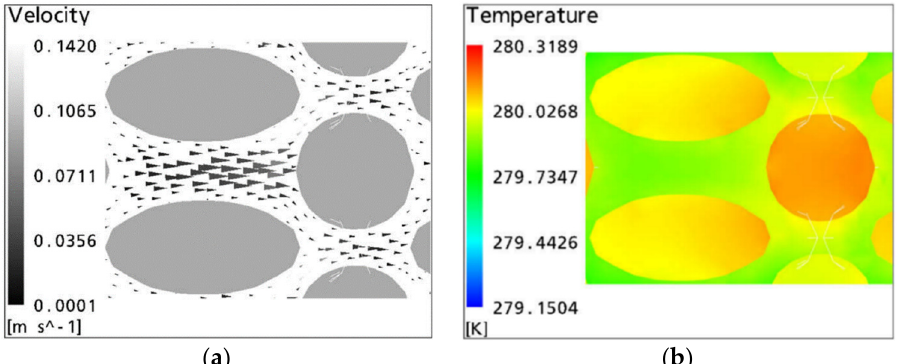
Figure 39. Results obtained for a set of operating conditions to visualize the ( a ) velocity field and ( b ) the temperature field during the solid regeneration after magnetization in a portion of the po- rous regenerator [60].